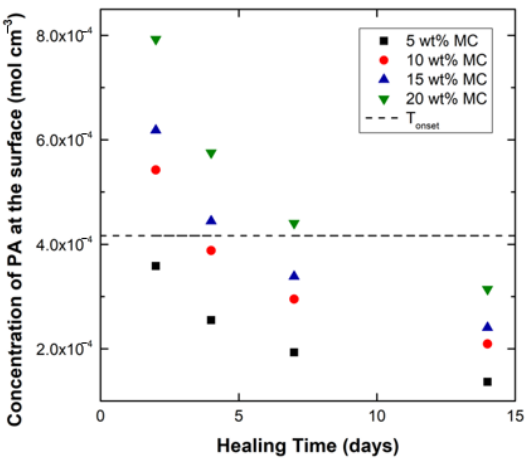
Figure 10. Calculated concentration of PA in the polymer for samples with varying microcapsule content at varied healing times (2, 4, 7, and 14 days). The concentration at which T onset = 25 °C is also